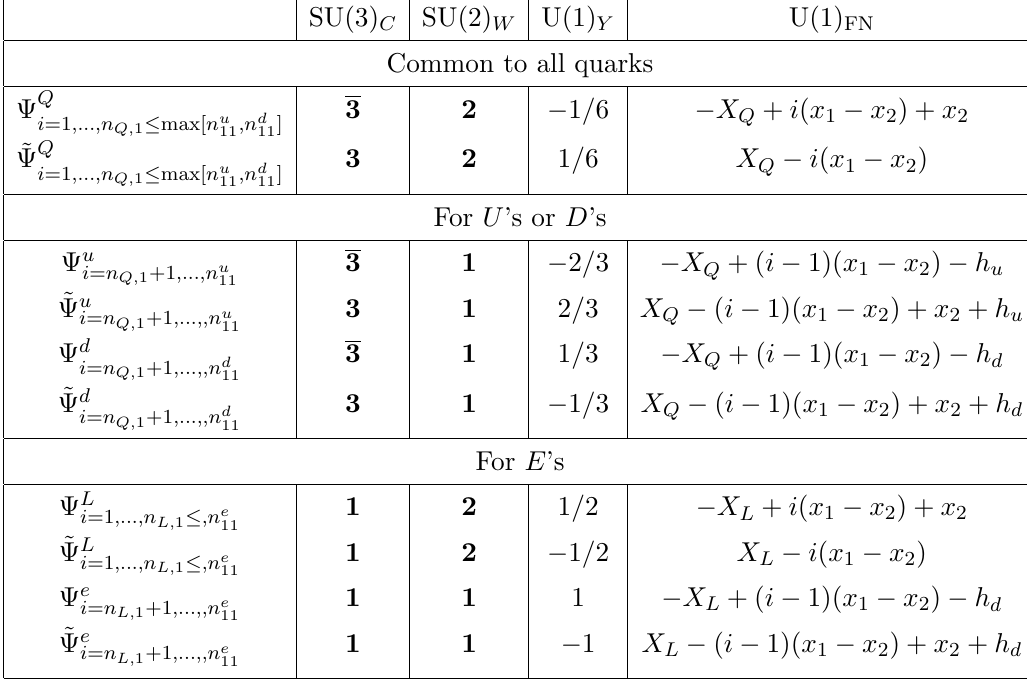
Table 2 . Gauge charges of the heavy FN